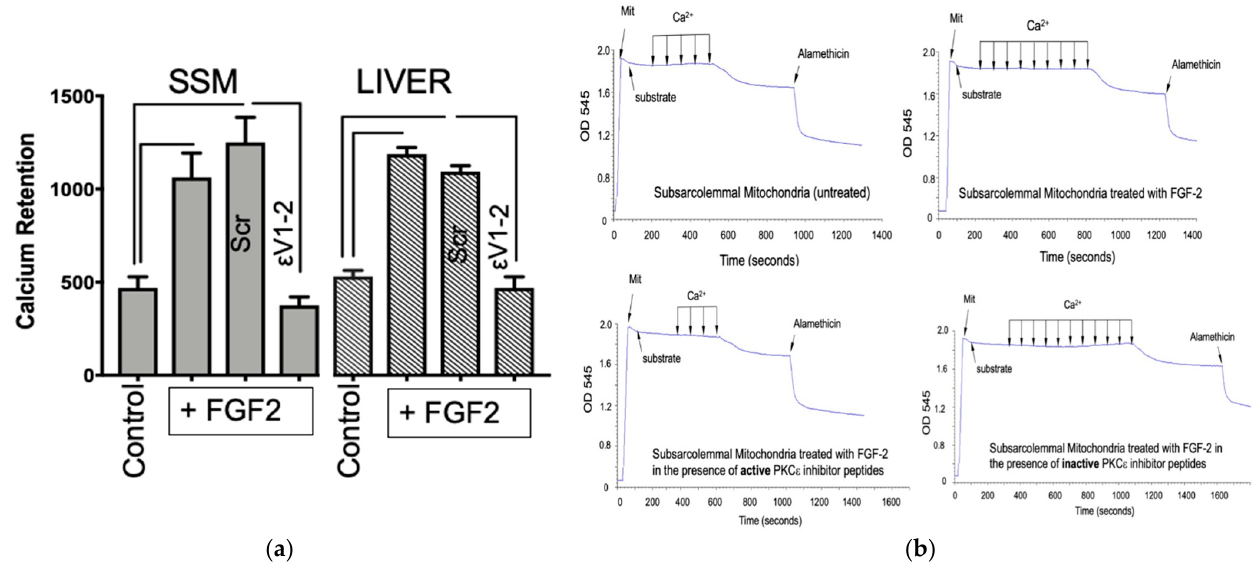
Figure 1. Direct exposure to Lo-FGF2 increases mitochondrial calcium retention capacity by a mito-PKC ε mechanism: ( a ) Lo-FGF2 significantly ( n = 4, p < 0.5) increases calcium retention capacity, expressed in µm Ca 2+ /mg protein, in both cardiac (SSM) and liver mitochondrial suspensions, as indicated. The PKC ε inhibitory peptide ε V1-2, but not the inactive scrambled (Scr) peptide, abolished the protective effect of FGF2. Brackets point to statistically significant differences between groups ( p < 0.05, n = 4); ( b ) representative tracings showing the changes in optical density, OD 545, values, (indicative of swelling and calcium capacity) in the different SSM groups as a function of time (seconds) and calcium increment. Arrows indicate each calcium increment (by 125 μ M).